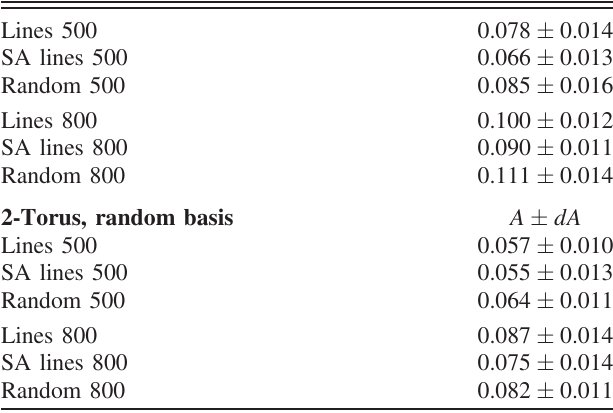
TABLE II. Mean and variance of A for the same networks as in Table I, now calculated using a random rather than the minimal basis. The L values are not affected by a shift in basis, so they are not included in the table.